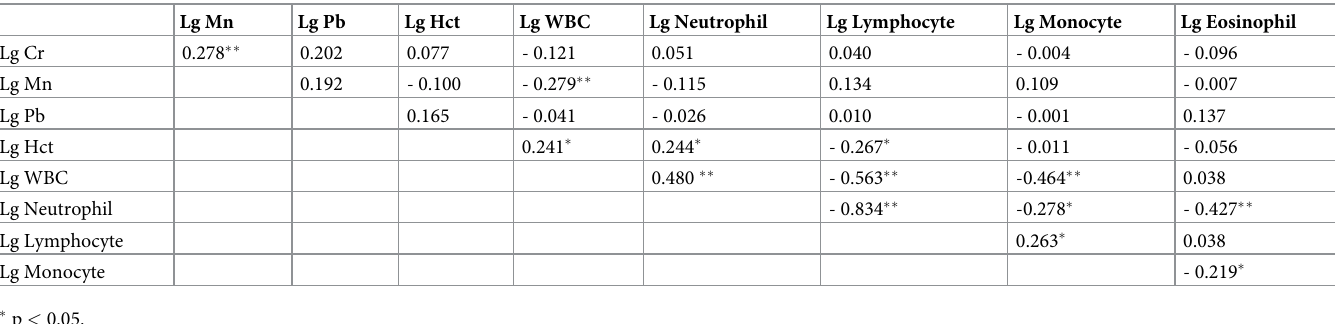
Table 4. Pearson correlation analysis for log-transformed urine metals and blood parameters.